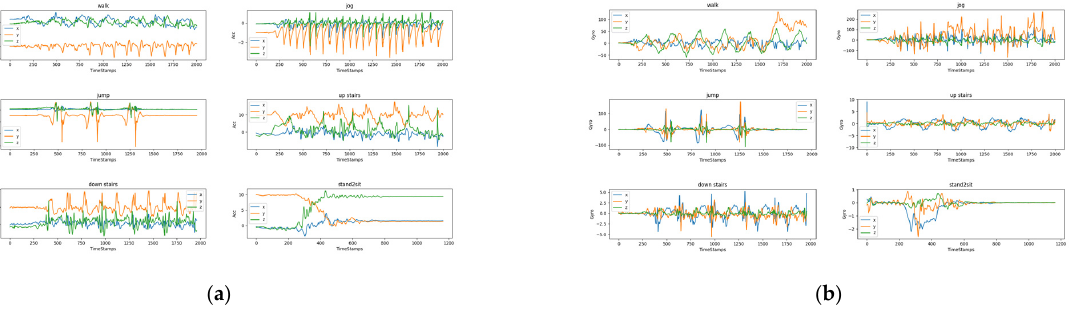
Figure 4. ( a ) Walking, jogging, jumping, going up stairs, going down stairs, sitting down accelera- graphs; ( b ) Walking, jogging, jumping, going up stairs, going down stairs, sitting down